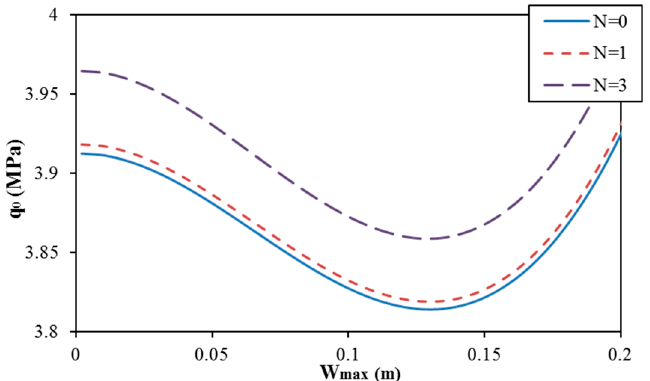
Figure 3. E ff ect of the number of waves of corrugation in a loop coil on the postbuckling curve of round spiral corrugated sandwich FGM cylindrical shells ( K 1 = 10 7 N / m 3 ; K 2 = 5 × 10 4 N / m, d = 0, r = 0.015 m, and k = 1).